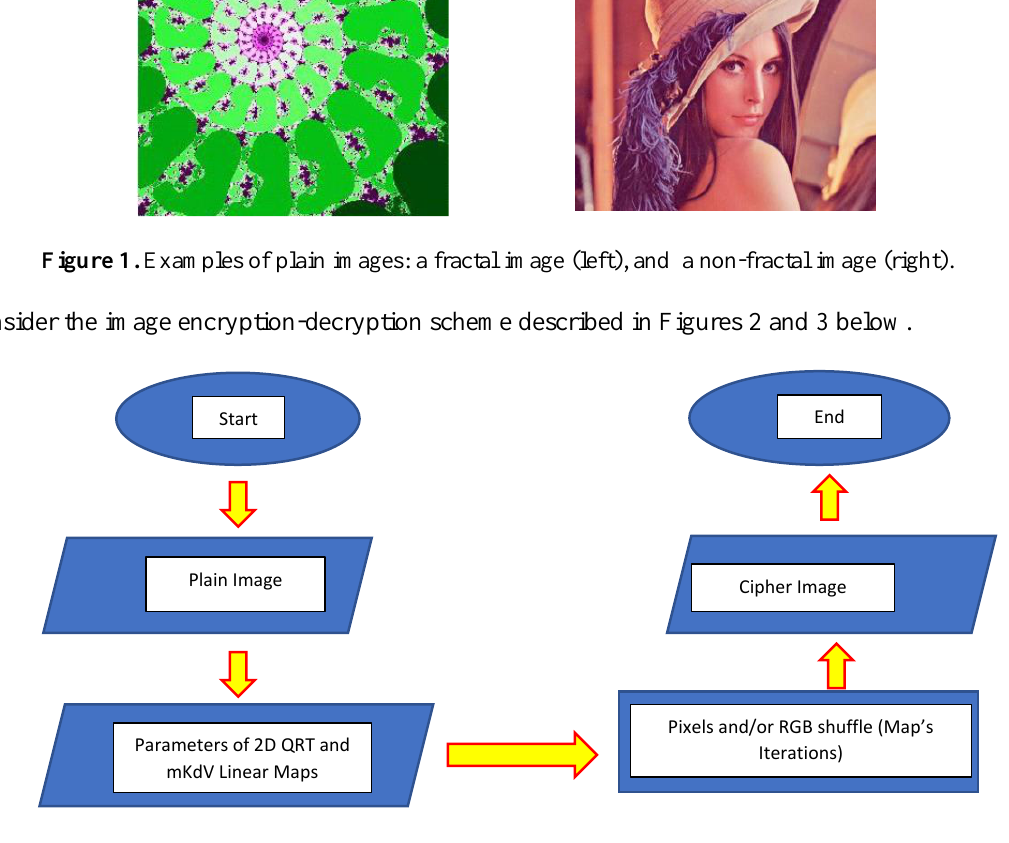
Figure 2. A flow chart for the proposed encryption algorithm.